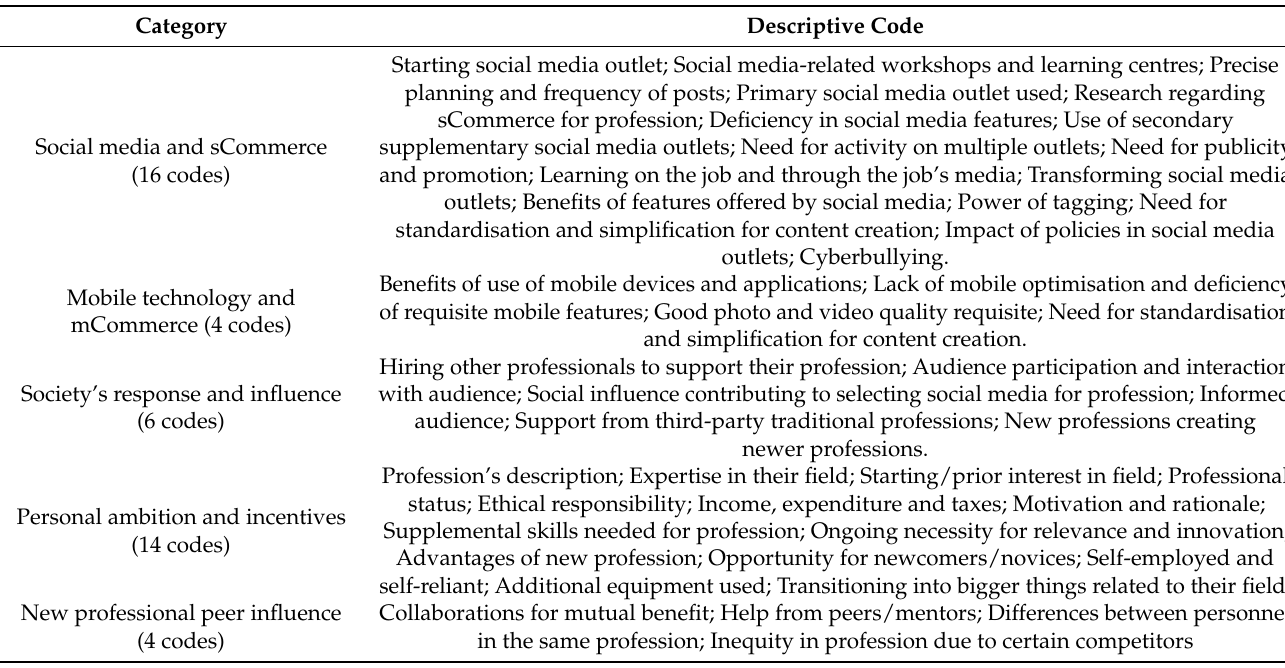
Table 2. Descriptive codes organized in five broad